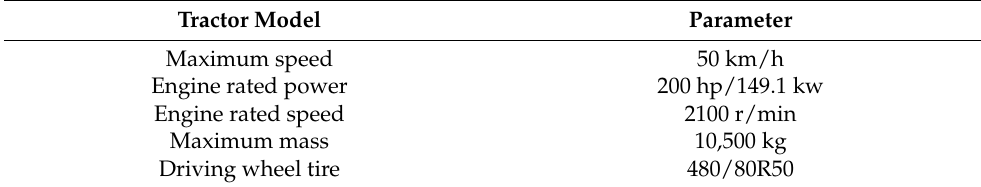
Table 4. Basic parameters of